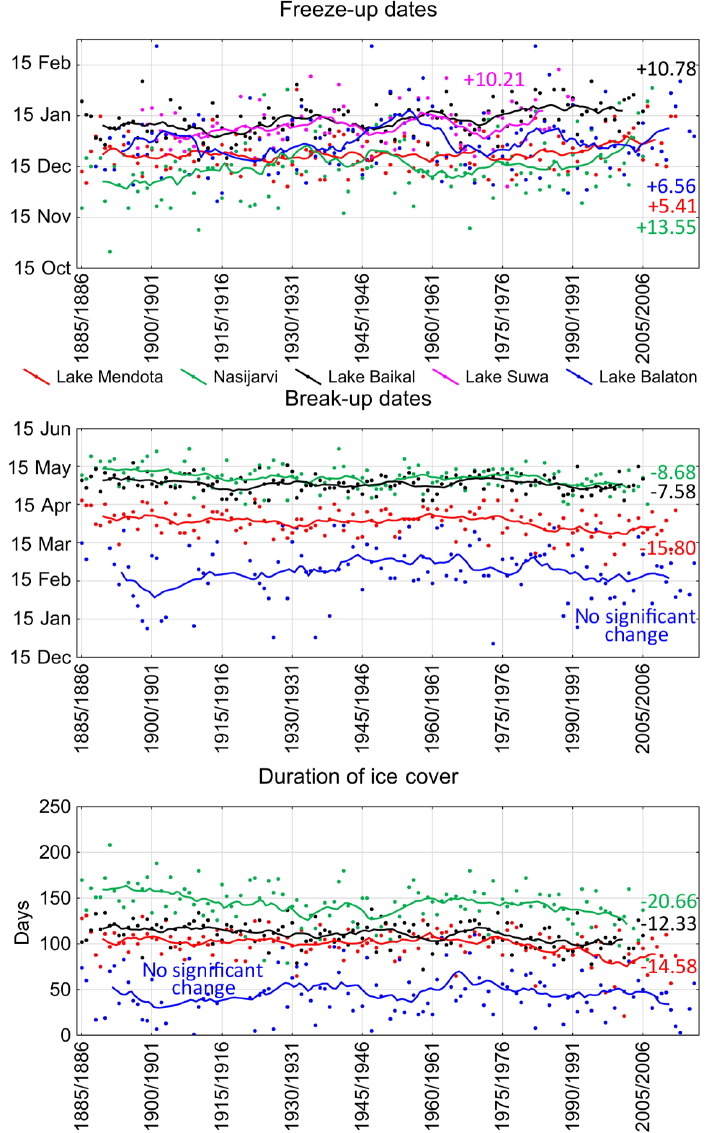
Figure 8. Variations in the dates of freeze-up and break-up on lakes Mendota, Näsijärvi, Baikal, Suwa, and Balaton from 1885 to 2017. (Data were smoothed using 10-year moving averages. Trend magnitudes are expressed in days/100 years and are marked with the same